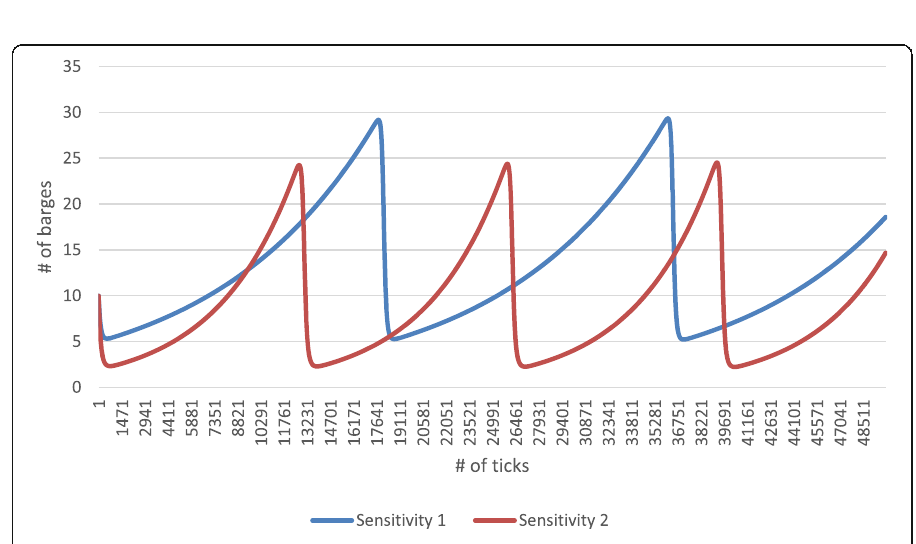
Fig. 8 Sensitivity Analysis for Case